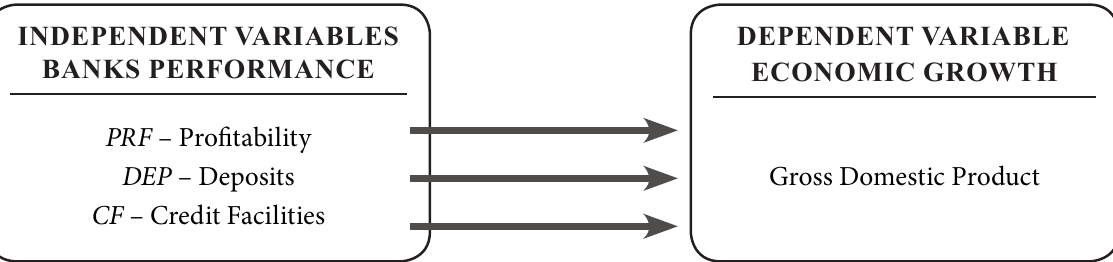
Figure 1. Conceptual